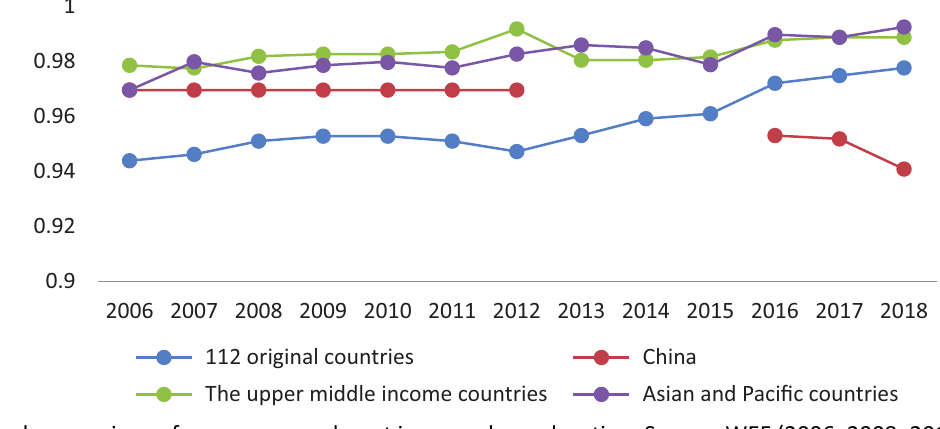
Figure 5. Trend comparison of scores on enrolment in secondary education. Source: WEF (2006, 2008–2018).